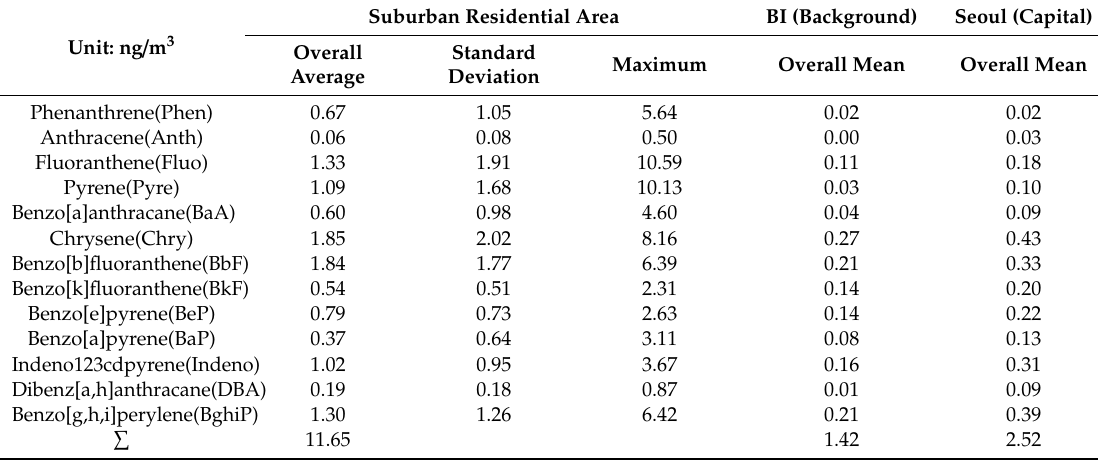
Table 1. PAH concentrations in the study area and major cities in